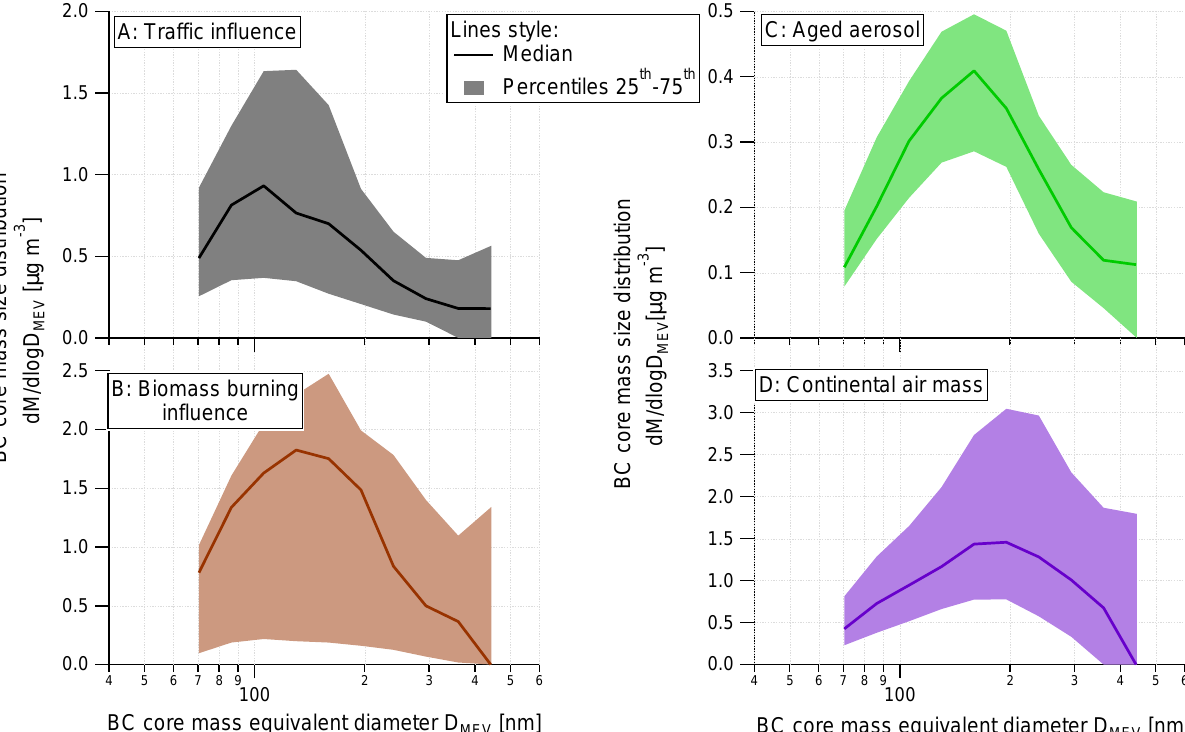
Fig. 10. Median, and 25 th and 75 th percentiles of BC core mass size distribution (SP2) for each air mass